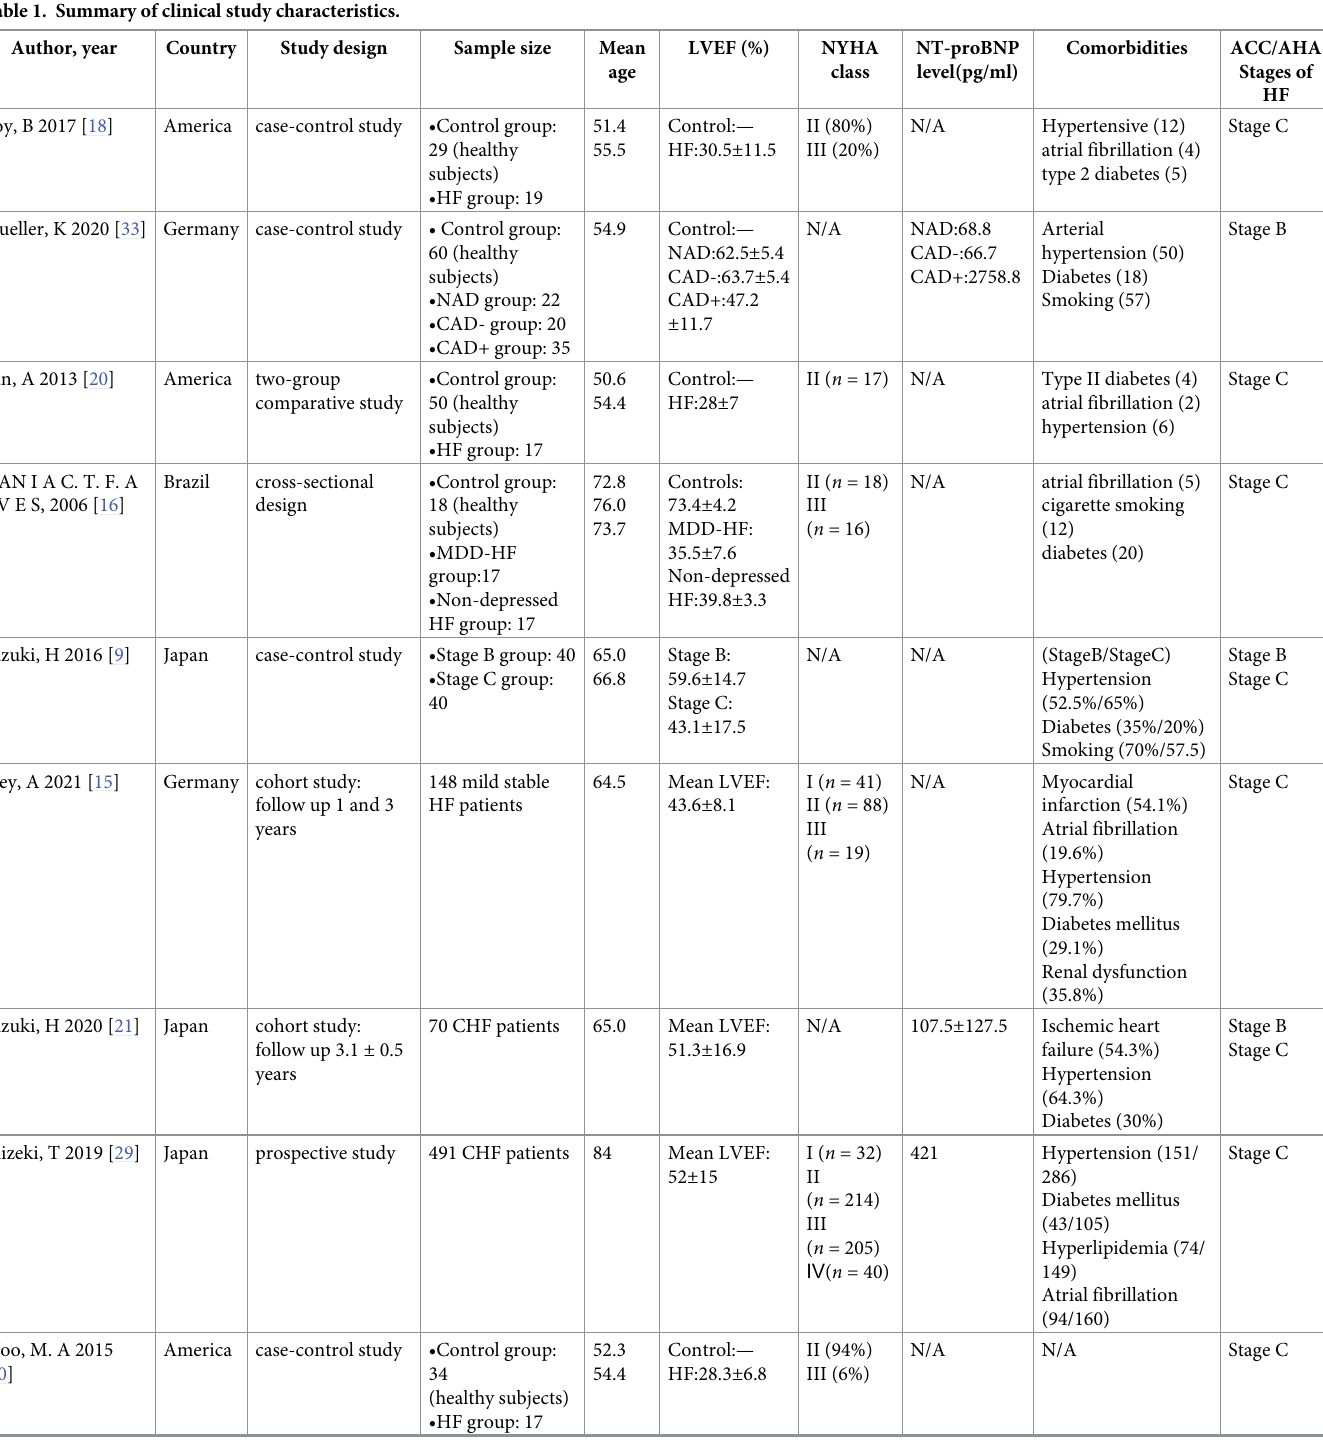
Table 1. Summary of clinical study